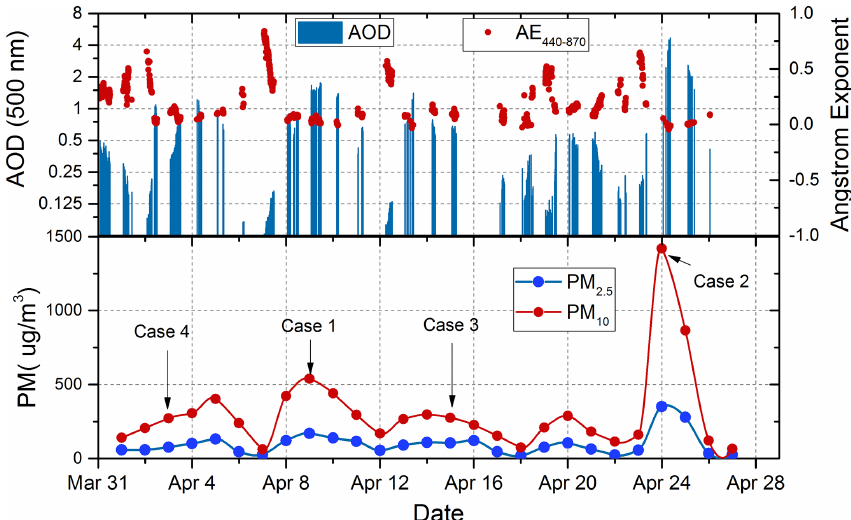
Figure 3. The AOD at 500nm, Ångström exponent (440–870) and daily particulate matter (in µgm − 3 ) in April 2019. The AODs are measured by the sun–sky photometer deployed at the Kashi site, and the data are stored in the SONET network. The particulate matter measurements are public data from a meteorological station 5km from the observation